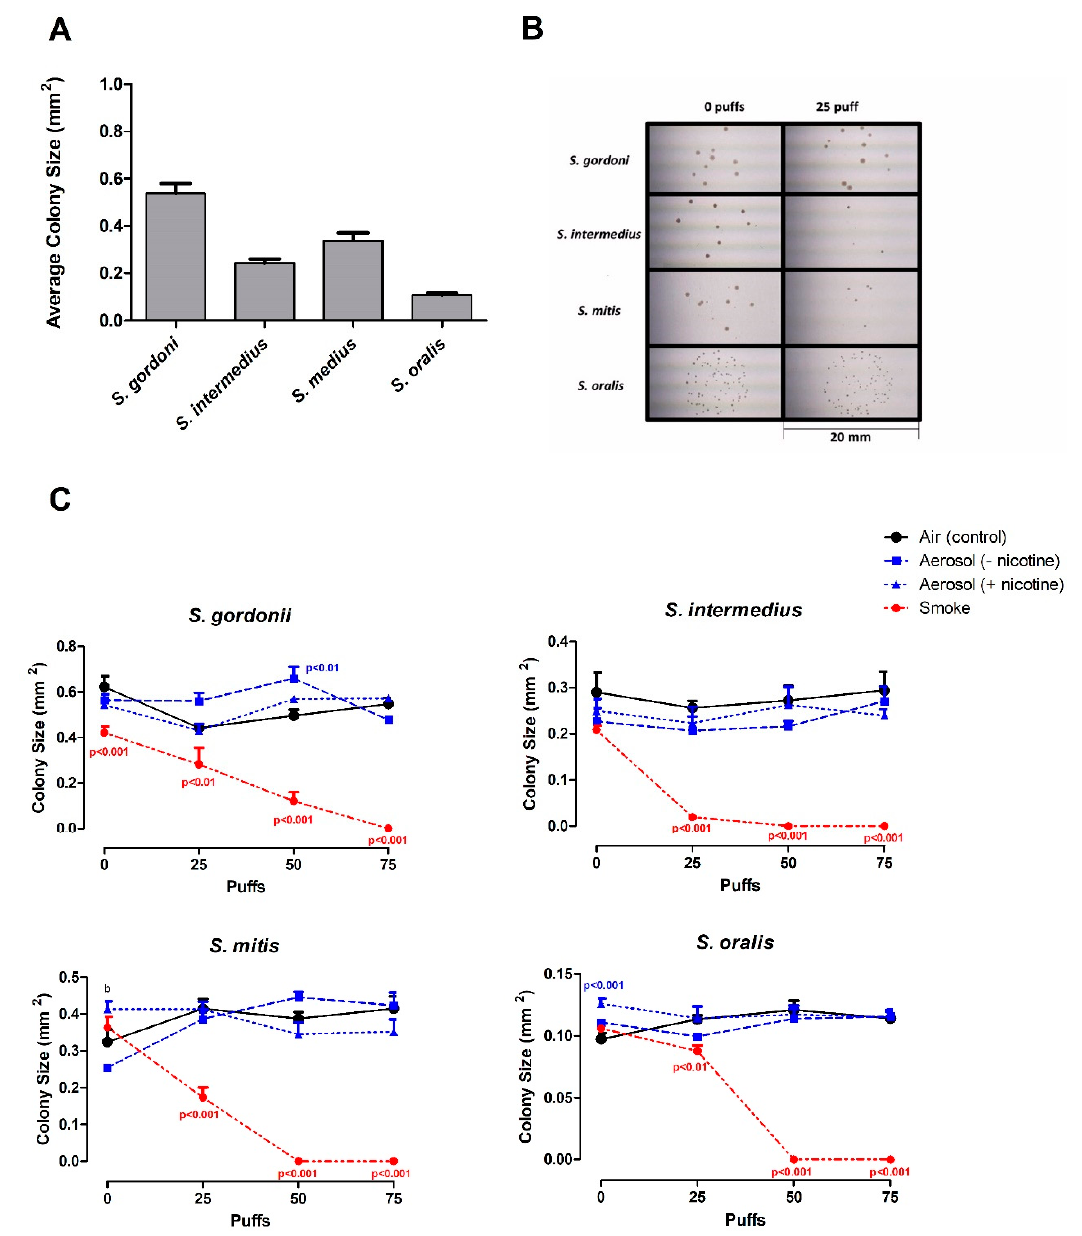
Figure 4. E ff ect of air, flavorless ECIG aerosol ( ± 20 mg / mL nicotine), or smoke (Marlboro ® Red cigarette) on CFU size. (A) Average colony size of commensal oral streptococci . The average of the three largest colonies in each quadrant of four agar plate (n = 16) were used to determine mean colony size for all bacteria at every exposure. Each data point is the Mean ± SE (mm 2 ). ( B) Representative images of colony sizes of commensal oral streptococci following exposure of 0 and 25 pu ff s of smoke (Marlboro ® Red cigarette). Each frame is 20 mm long. ( C) E ff ect of air (control), aerosol ( ± 20 mg / mL nicotine), or smoke (Marlboro ® Red cigarette) on colony size of commensal oral streptococci . Each data point is Mean ± SE, n = 4, p values indicate significance from control. b = p < 0.001 between aerosol with nicotine and without nicotine.